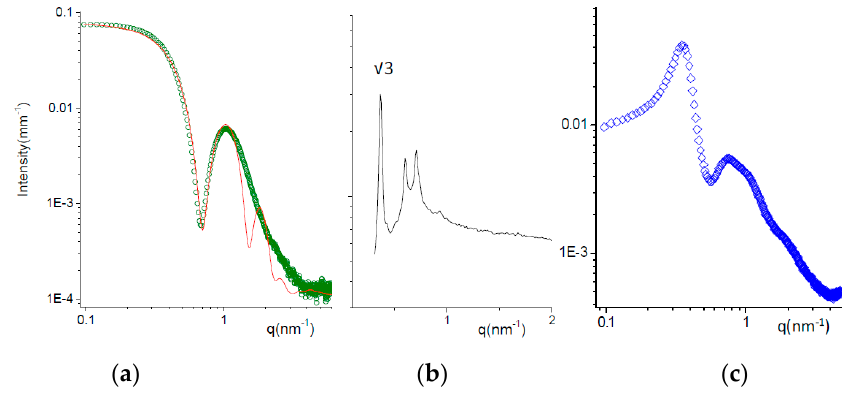
Figure 2. SAXS spectra of micellar solutions at T = 25 °C. ( a ) Formulation T (green dots); fitting curve (red line) obtained with a core-shell-sphere model for the micellar form factor combined with a hard-sphere structure factor. ( b ) Formulation P (black line). The position of characteristic peaks are reported in the Supplementary Materials. The ratio between the first observed peak and the first order peak position q * is reported. The ordered phase is a face-centered cubic (FCC) micellar phase. ( c ) Formulation TP (50:50 mole ratio).